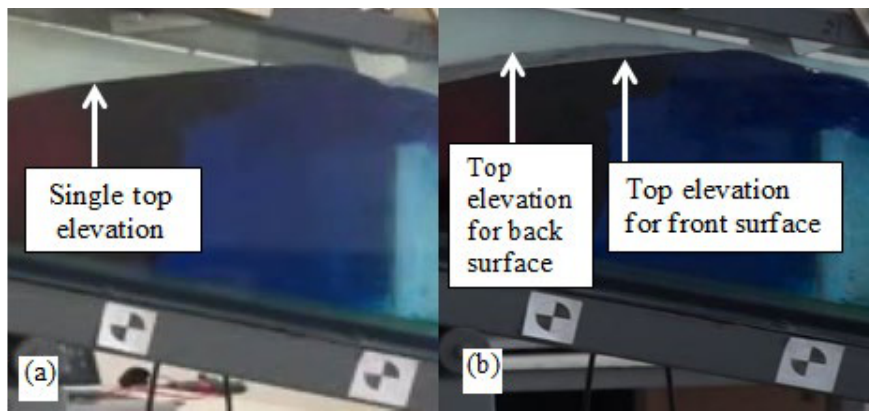
Figure 10. Top elevations for the cameras ( a ) Camera-1 ( b ) Camera-2.